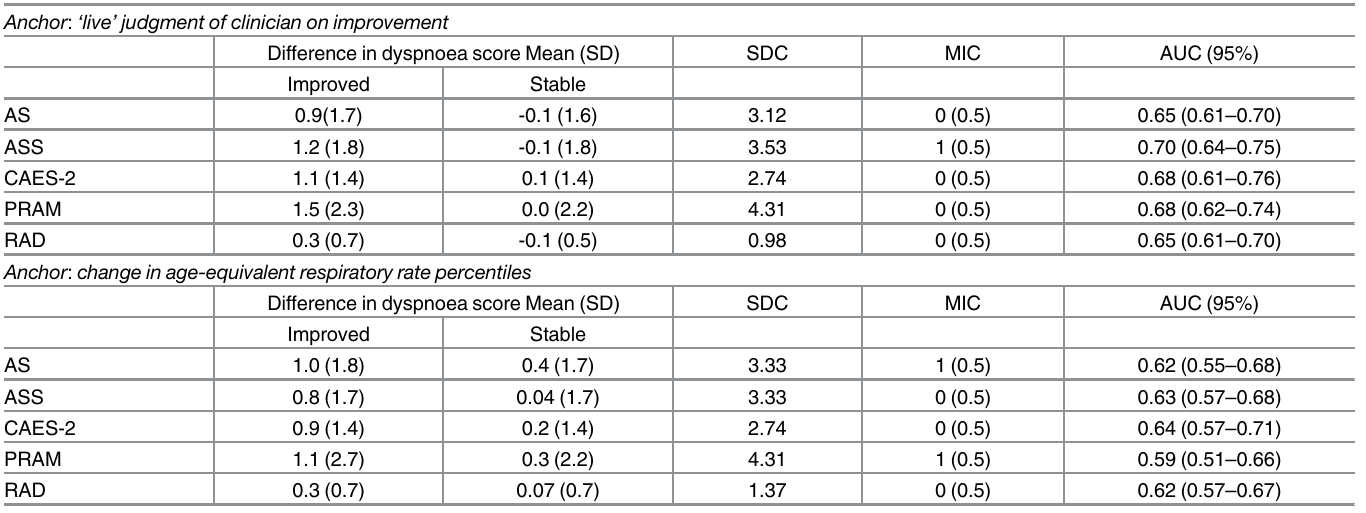
Table 4. Agreement and responsiveness of the five dyspnoea scores using different anchors of change. Anchor : ‘ live ’ judgment of clinician on